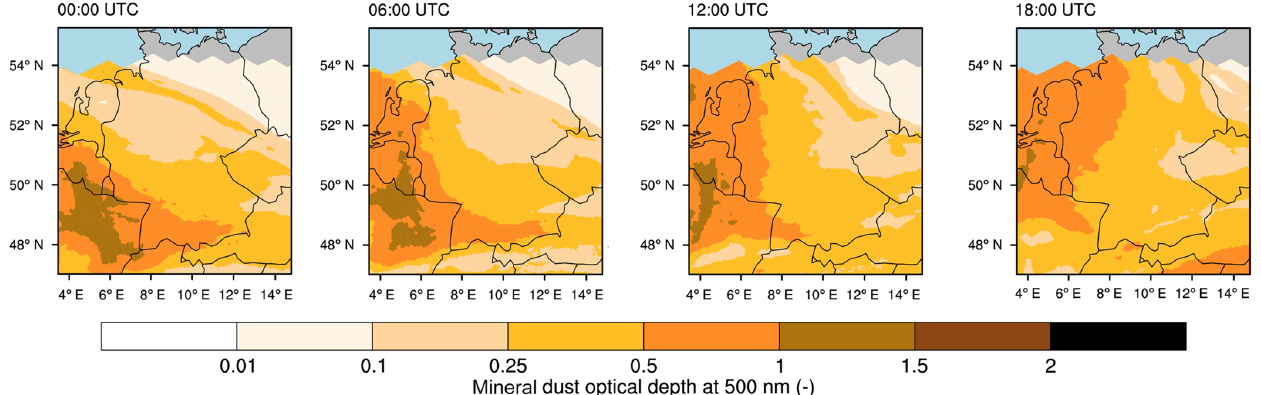
Figure 6. Mineral dust optical depth at 500nm over Germany on 4 April 2014 at 00:00UTC, 06:00UTC, 12:00UTC and 18:00UTC (TT case). Note the saw-tooth shape in the northern part which marks the margin of the high-resolution (5km) domain and must not be confused with mineral dust-free conditions.